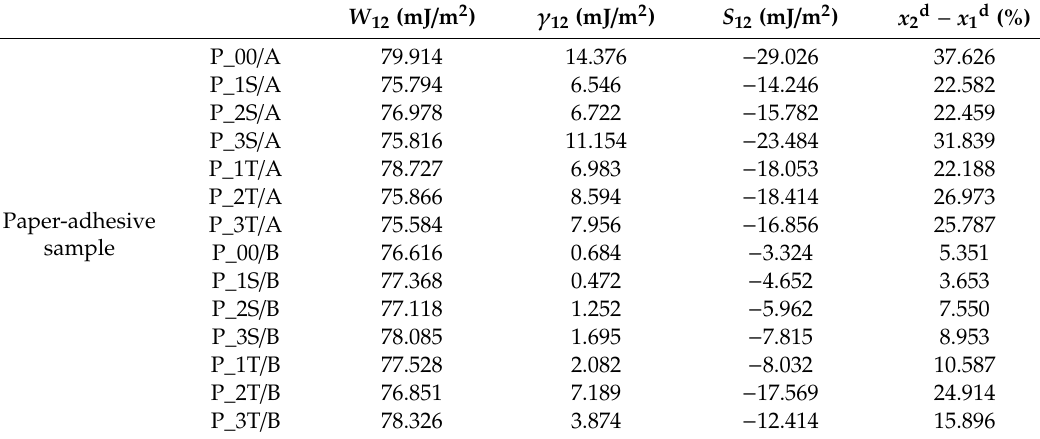
Table 6. Adhesion parameters for paper-adhesive samples: work of adhesion ( W 12 ), SFE of interphase ( γ 12 ), wetting coefficient ( S 12 ) and difference between paper and paper-adhesive dispersive index ( x 2d − x 1d